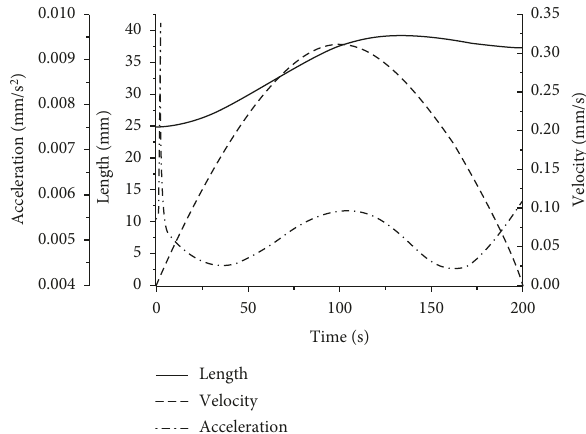
Figure 16: Dynamic curves of the spacecraft’s center of mass.